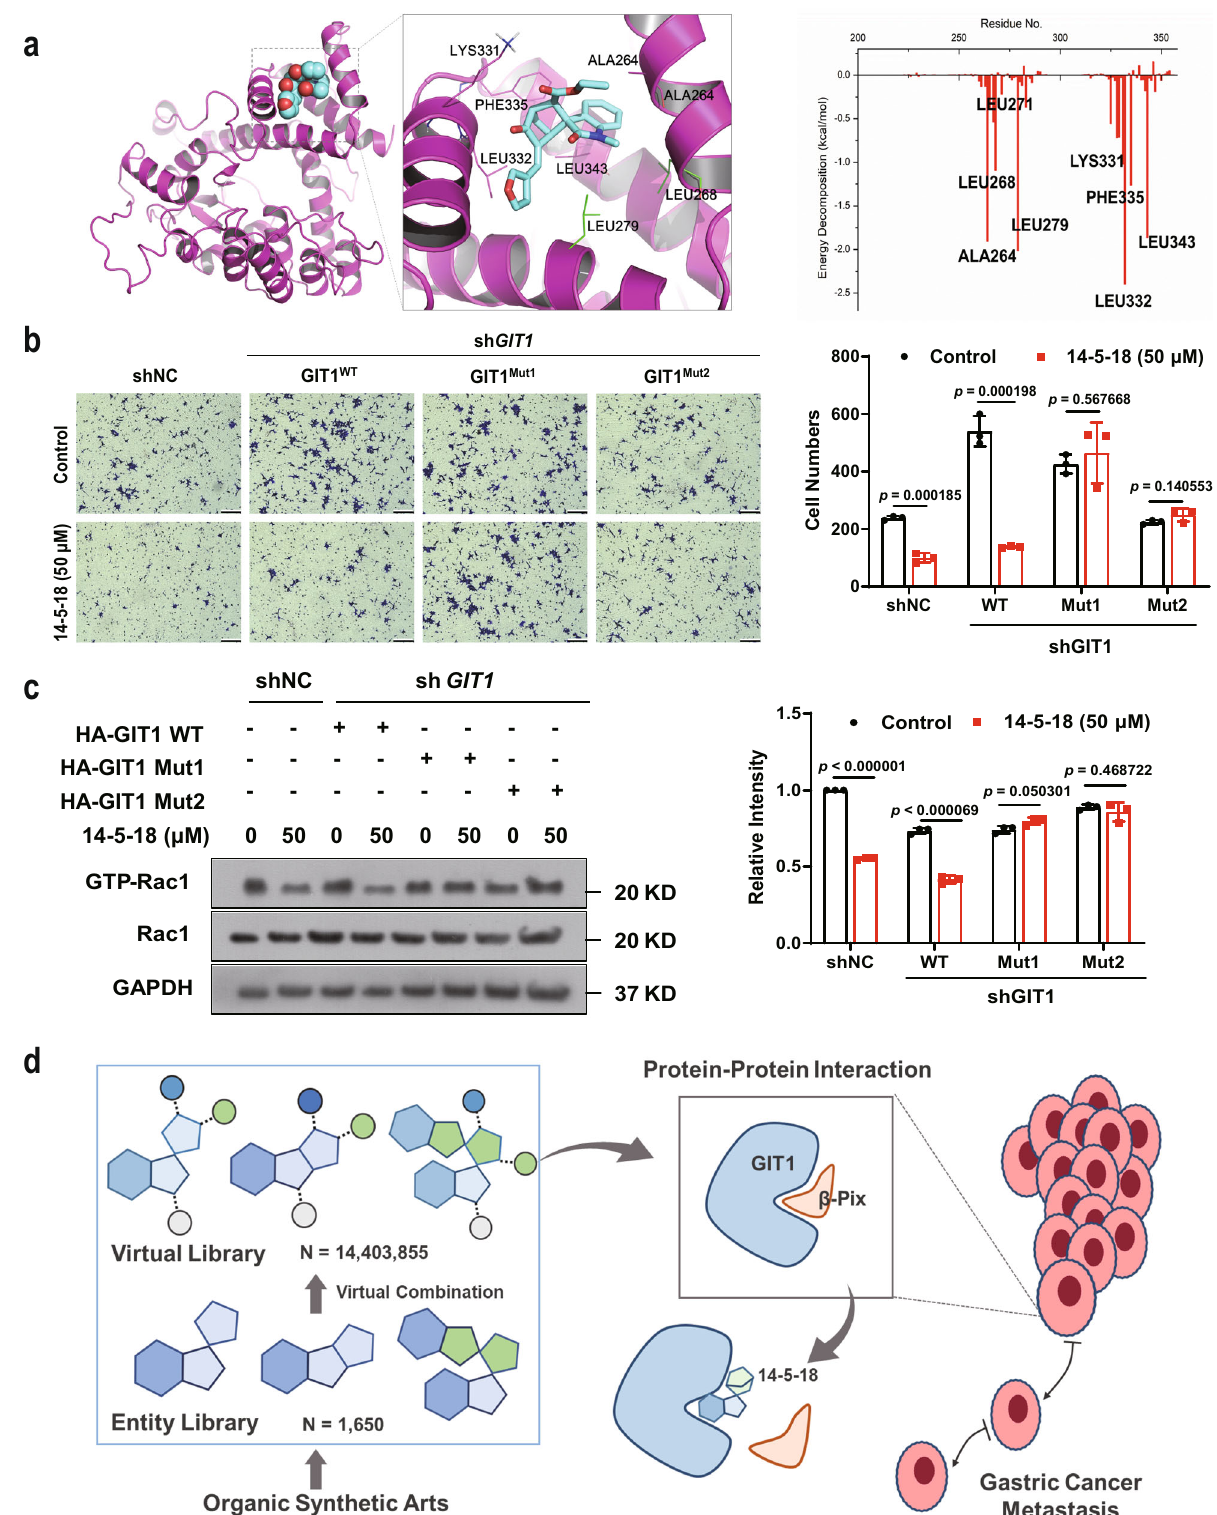
Fig. 5 | Compound 14-5-18 targets the GIT1/ β -Pix interaction at GIT1 residues Leu271andLeu279.a CartoonmodelshowingthebindingposeofGIT1(magenta) and 14-5-18 (cyan). Magni fi cation of the binding pocket (middle) indicates the key residues(inlines)adjacentto 14-5-18 (insticks).Thegraph(right)showstheenergy decomposition of each adjacent residue. b Transwell invasion assay to detect the invasion abilities of MKN45 cells with wide-type or mutant GIT1, with or without